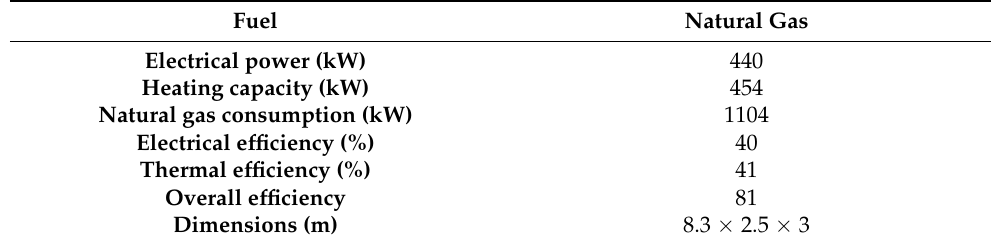
Table 6. PAFC Doosan PureCell 400